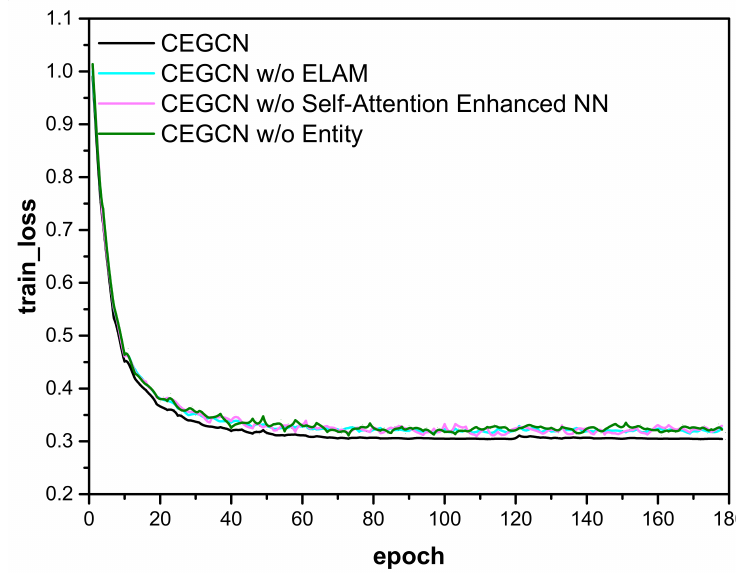
Figure 6. The train_loss for variant models of the ablation study.